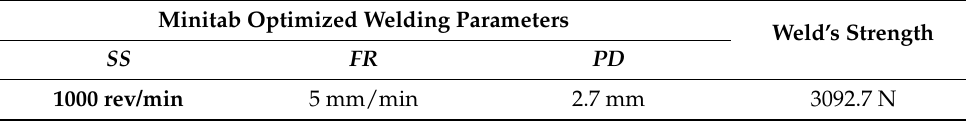
Table 3. Combination of the optimized static welding parameters.